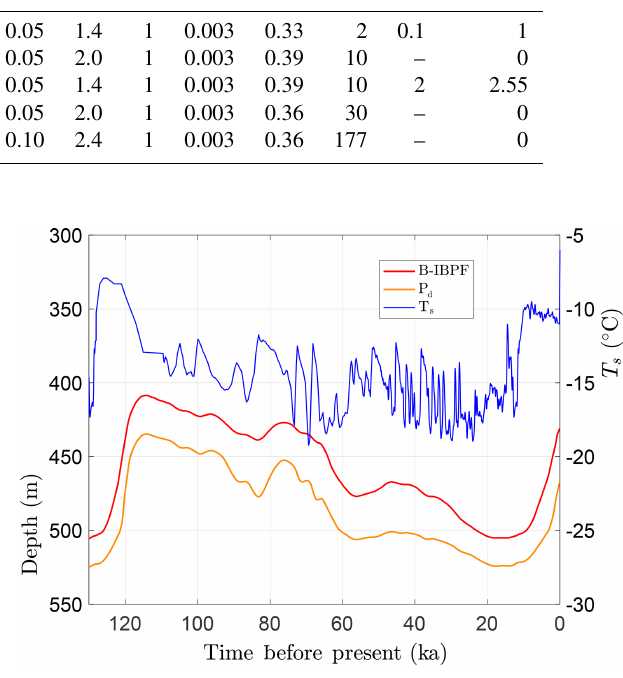
Figure 9. Upper boundary condition ( T s ) used to explore the re- sponse of a sedimentary sequence (Fig. 8, Table5) to surface- temperature changes over the last ice-age cycle. Also shown are the depths for the base of permafrost ( P d ) and the base of ice-bearing permafrost (B-IBPF) predicted by the CVPM